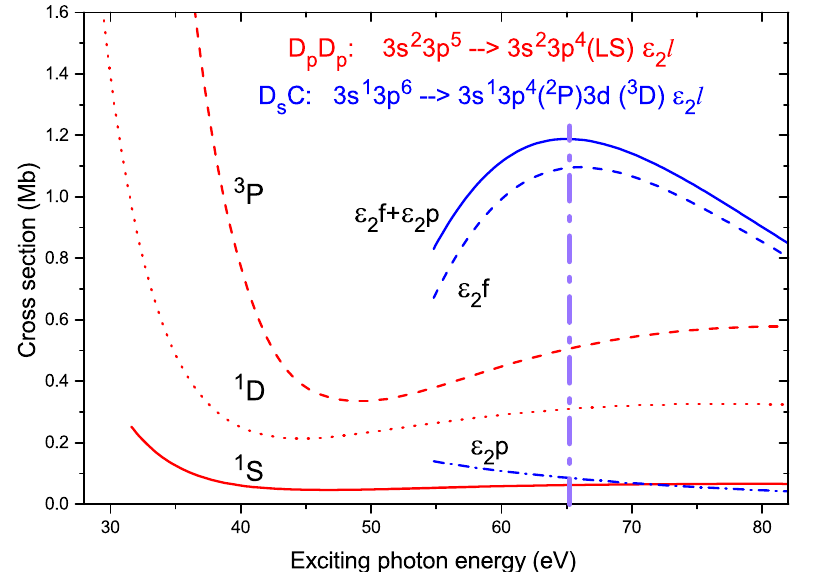
Figure 4. Calculated photoionization cross section(s) (PICS) for the second step of the direct 3 s 2 3 p 5 (cid:57)(cid:57)(cid:75) 3 s 2 3 p 4 ε 2 (cid:96) and the largest correlational 3 s 1 3 p 6 (cid:57)(cid:57)(cid:75) 3 s 1 3 p 4 3 d 1 ε 2 (cid:96) 2PDI transitions of Ar. For the correlational transition, partial PICS are also shown. The vertical dash-dotted line shows the photon excitation energy used for computing the photoelectron spectrum in Figure